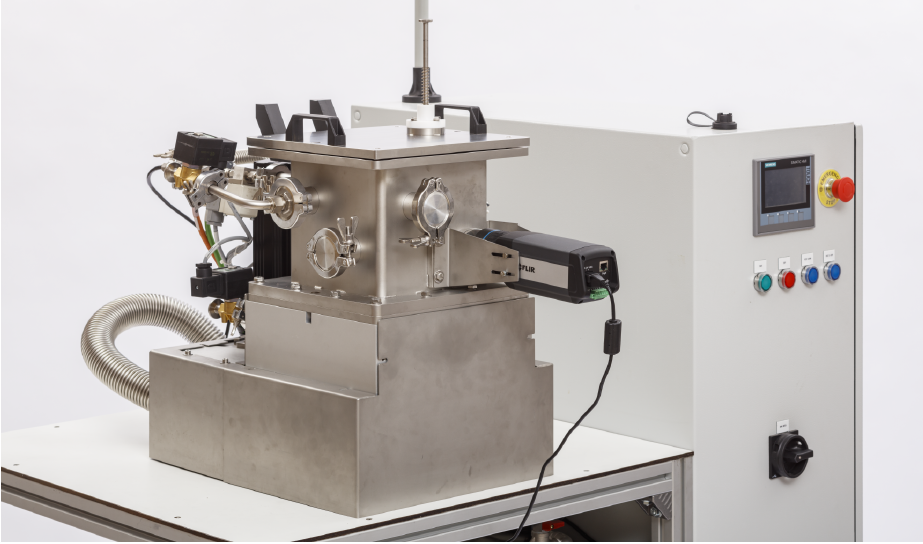
Figure 2. Single-vial continuous freeze-drying